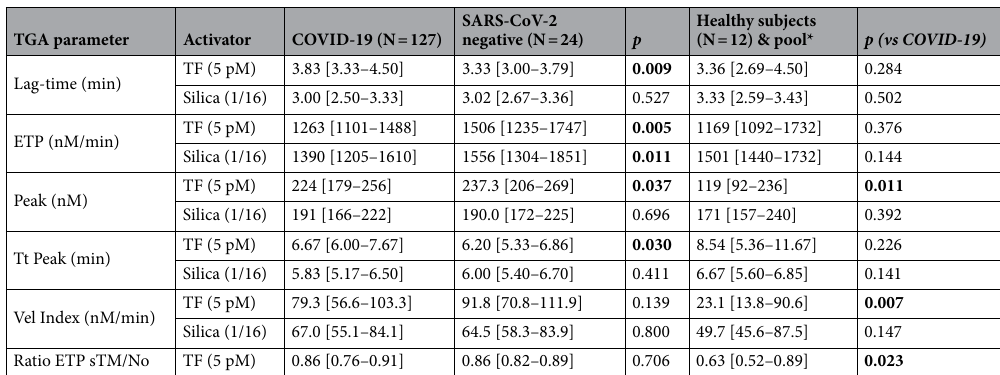
Table 4. Baseline thrombin generation parameters of plasma samples from pneumonia patients with or without COVID-19 and healthy controls. Values are expressed as median [IQR]. Bold values denote statistical significance at the p < 0.05 level. *Plasma pool of 100 blood donors. sTM soluble thrombomodulin, TF Tissue factor, TGA thrombin generation assay, Tt Peak time to peak, Vel Index velocity index. P values were based on Mann–Whitney-U